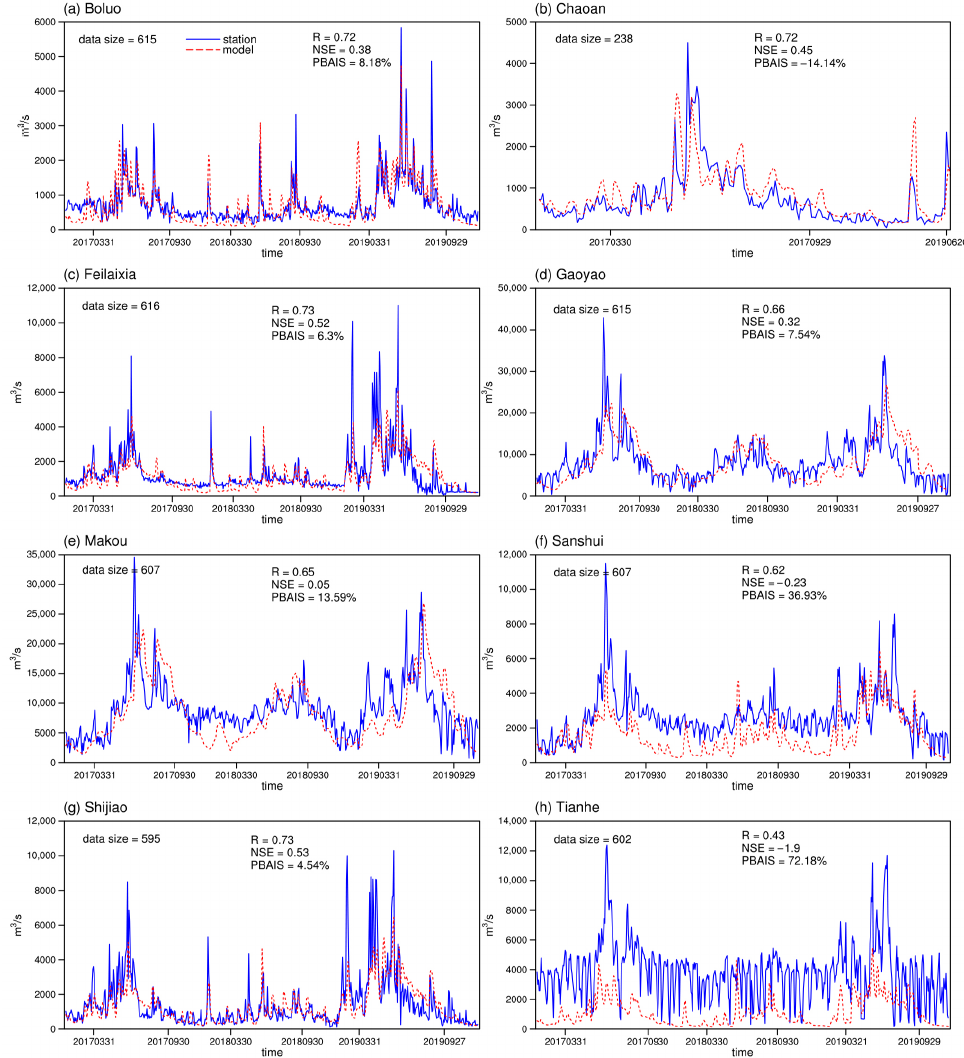
Figure 2. DRIVE simulated streamflow against observed data for eight stations in Guangdong province, and the metrics for model performance in the streamflow